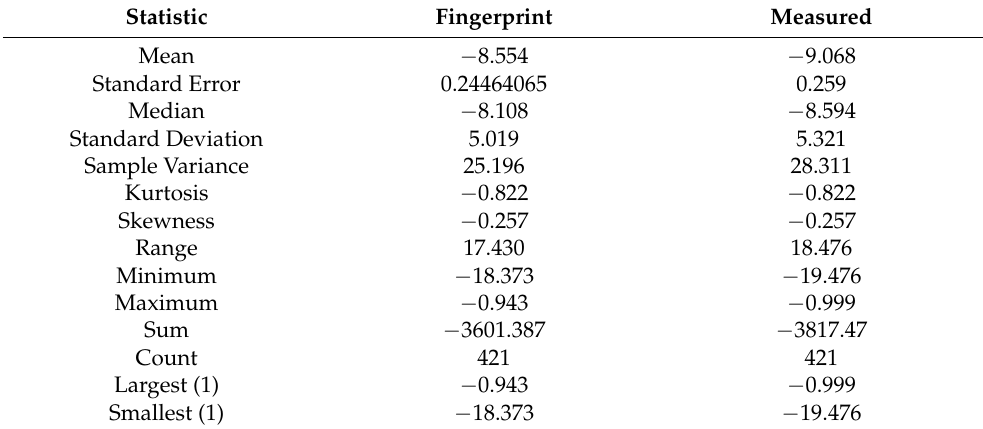
Table 9. Sub-region 1: Descriptive statistics comparison between fingerprint and measured FRA profiles.